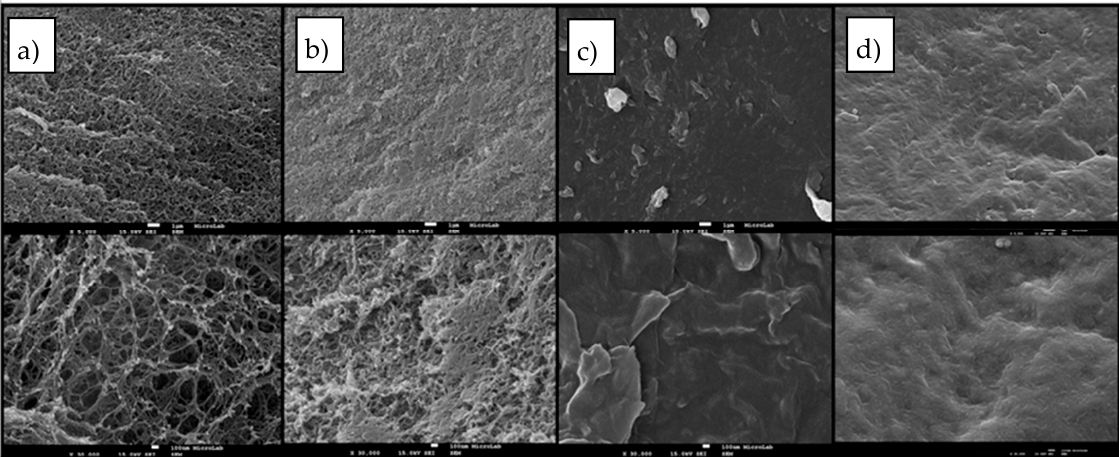
Figure 11. SEM images of alginate aerogels: ( a ) blank, ( b ) Zn(II)-AHBD impregnation, ( c ) Zn(II)-AHBD + [Aliquat][Cl] impregnation and ( d ) [Aliquat][Cl] impregnation. The first line corresponds to a 5.000 magnification and the second line to a 30.000 magnification.